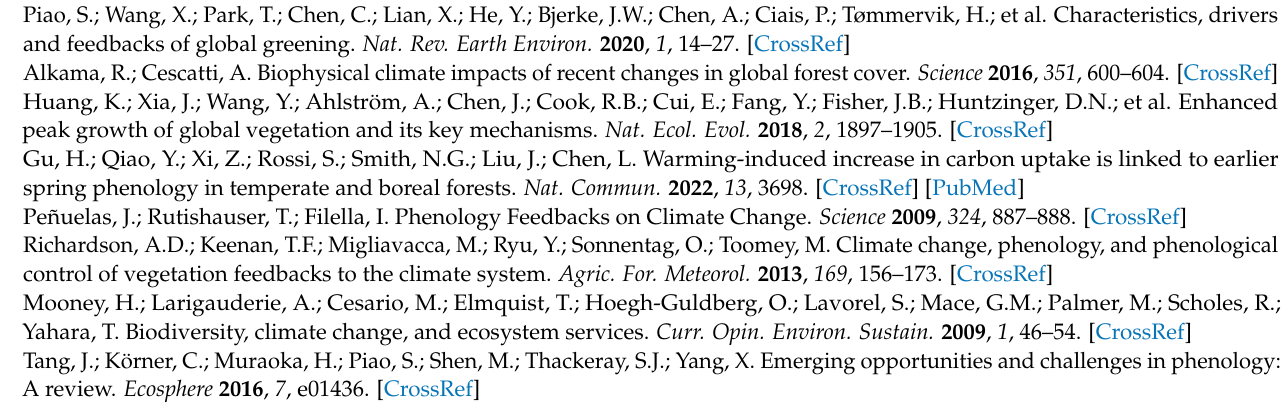
literature reference of sites used in this study. The numbers in column “#N” refer to the station numbering in Figure 1. Figure S1: Characterization of stations “Algeria 5” (top), “Hesse” (middle), and “Piedmont (rice cultivation” (bottom)). The white dashed circle represents a 1 km footprint around the station center coordinate. Table S2: Correlation coefficient (above diagonal) and Mean Absolute Difference (MAD, below diagonal) of the different compositing approaches, averaged over all monthly composites. Figure S2: Variance (left) and maximum difference (right) in NDVI estimates derived from all 11 compositing variants for the monthly composite of April 2007. Figure S3: NDVI maps for decade 2 October 2007 based on the different compositing approaches. Figure S4: Daily NDVI maps from 23 June 2007, based on the different compositing approaches. Figure S5: Zoom to focus areas D (left column), E (middle column), and F (right column) of the monthly NDVI maps based on the different compositing approaches. For focus area locations, see Figure 1. Figure S6: Time series of (A) daily, (B) decadal, and (C) monthly NDVI at the Algeria 5 (desert site, top), Hesse (forest site, middle), and Piedmont (agriculture site, bottom) stations, split up showing the single variable composites (MVC, MED, Sa, Su, Az, and Uc) on the left and the multiple variable composites (NAUc, AN, SuSaAzUc, AUc, and MOD) on the right. In black, the MOD13A2 (16 days interpolated to decadal and daily intervals, A and B) and MOD13A3 (monthly, C) is plotted as reference. Figure S7: Deviation of the decadal composites generated with different compositing approaches from MODIS NDVI at 37 stations. Figure S8: Deviation of the daily composites generated with different compositing approaches from MODIS NDVI at 37 stations. Figure S9: Spatial representation of neighborhood homogeneity. Table S3: Description of all data layers of the final L3 monthly NDVI